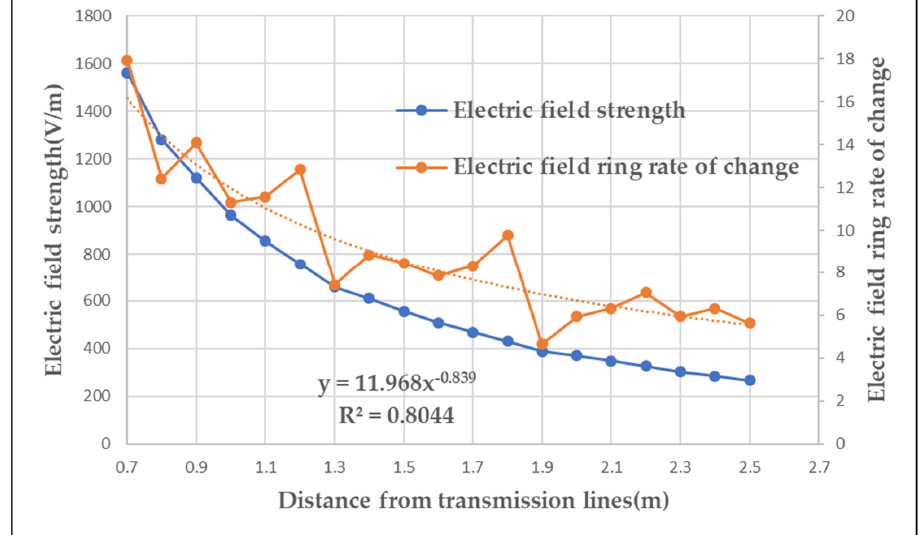
Figure 21. K curve of electric field strength and ring ratio change rate of the electric field. The blue curve in the figure shows that the electric field strength measured by the electric field measurement system was negatively correlated with the distance of the system from the transmission line, which is consistent with the theoretical analysis. The orange curve in the figure indicates the change curve of the electric field annular rate of change, and it can be seen that there were fluctuations in the curve, which is different from the results obtained from the simulation in Chapter 3. By adding the trend line of the orange curve, which is the orange dashed line in the figure, it can be seen that the Y value corresponding to the orange dashed line was negatively correlated with the X value, which indicates that the K value of the measured data can reflect the relationship between